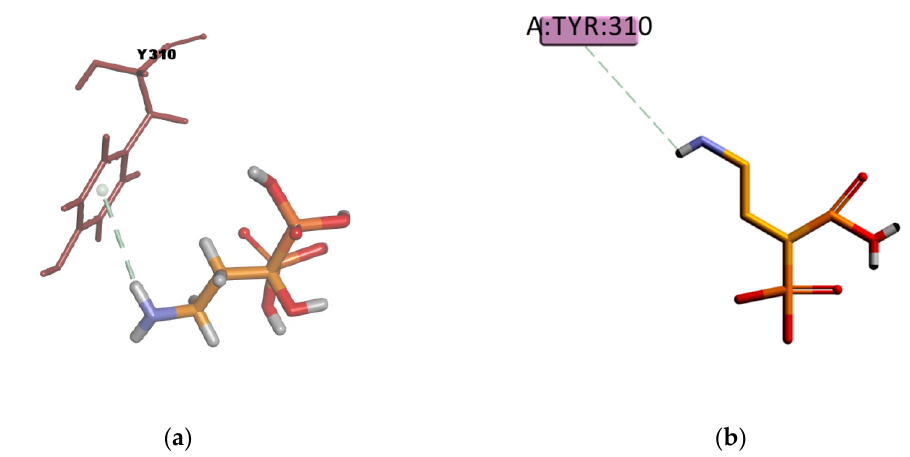
Figure 23. Pamidronate (APD) top-ranked pose obtained with CDOCKER algorithm. ( a ) 3D view of VPA interactions in the binding pocket. The light-green dotted line represents a π –donor hydrogen bond interaction; ( b ) 2D interaction diagram of APD with h P-gp interacting residues. The light-green dotted line represents a π –donor hydrogen bond interaction with residue Y310.